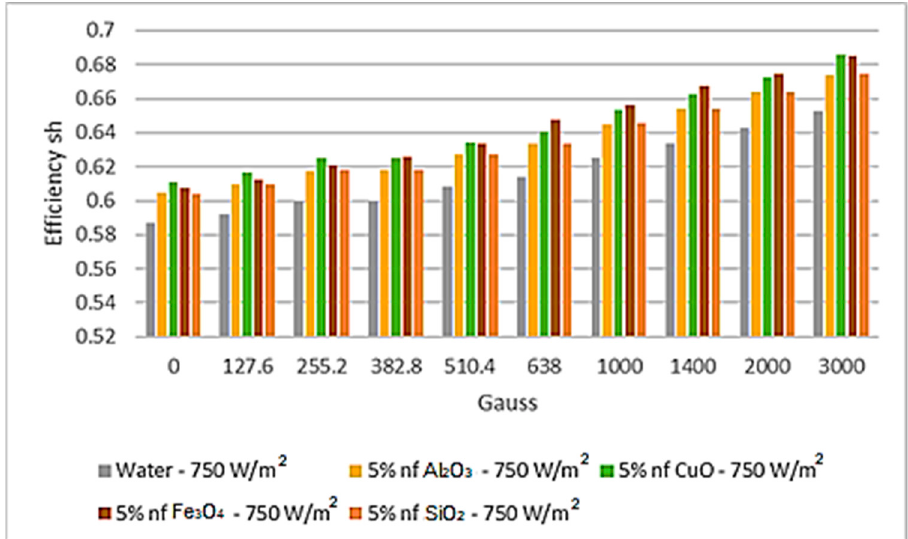
Figure 22. Hybrid system efficiency with different nanofluids.